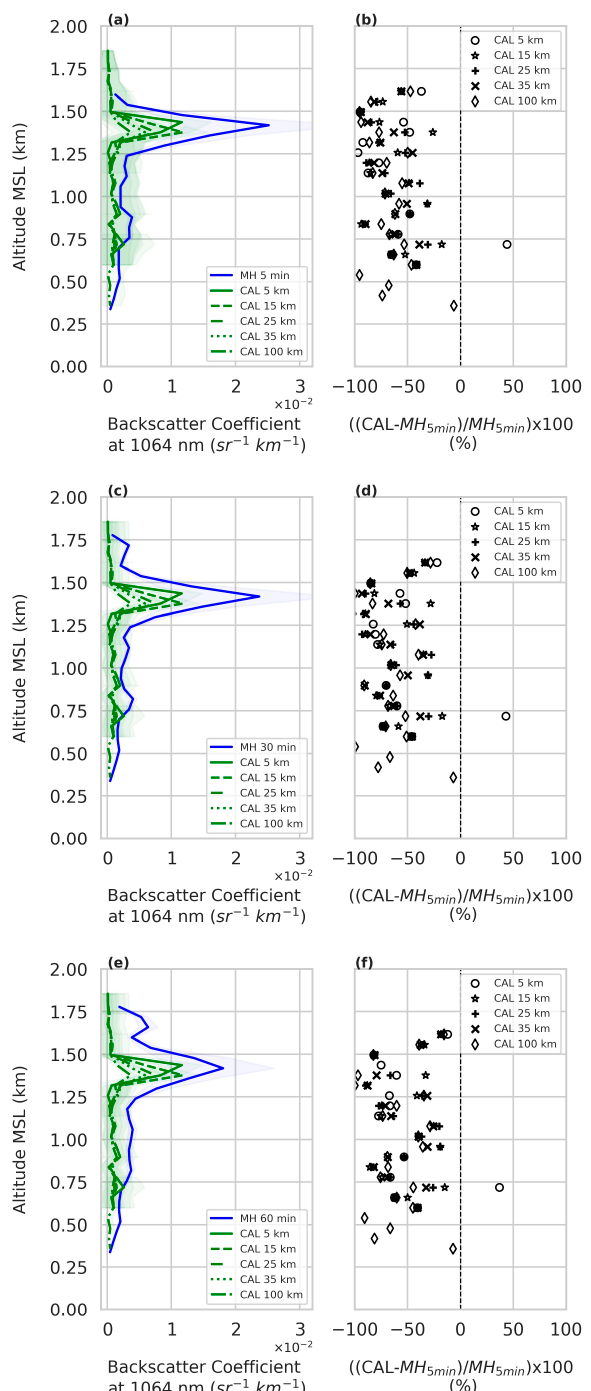
Figure A2. Backscatter Coe ffi cient at 1064 nm profiles and the corresponding mean percentage di ff erence as a function of altitude m.s.l for a CALIOP overpass at Mace Head on 19 July 2016 (case with a thin cloud) at 03:11:35 UTC at 60.11 km distance from Mace Head. The comparison uses CALIOP 5 km, 15 km, 25 km, 35 km, and 100 km along–track averages (1, 3, 5, 7 and 20 vertical profiles) and di ff erent temporal resolutions calculated for Mace Head data ( a,b ) 5 min (1 vertical profile) ( c,d ) 30 min Table A3. Statistical results (Mean Bias (B), Correlation Coefficient (R) and p value) derived from (6 vertical profiles) and ( e,f ) 60 min (12 vertical profiles). The shaded areas represent the standard deviation of the simultaneous measurements between CALIOP and Mace Head data for a cloud–free case (18/11/14) and for a case with a thin cloud (19/07/16) considering different along–track averages in CALIOP data (5 km, 15 km, 25 km, 35 km, and 100 km) and 5 min temporal resolution in Mace Head data.